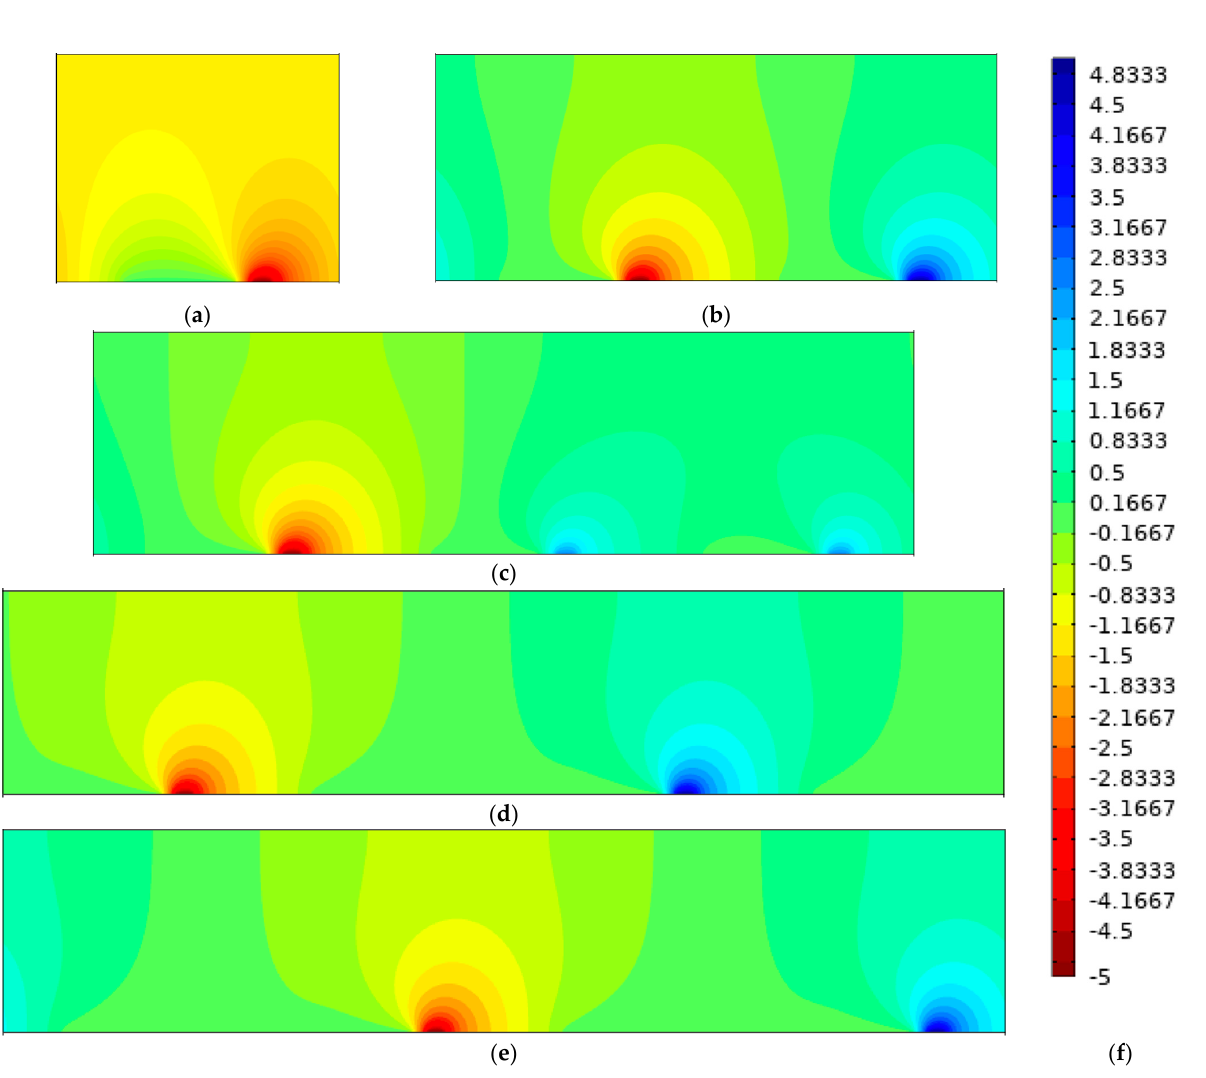
Figure 3. The real component of the voltage profiles is given for ( a ) 1-phase, ( b ) 2-phase (180 ◦ phase separation), ( c ) 3-phase (120 ◦ phase separation) and ( d ) 4-phase (90 ◦ phase separation) configurations at 5 V peak , where the far-left electrode is set to a phase angle of 0 ◦ . ( e ) shows the imaginary component of the electric field corresponding to the 4-phase configuration in ( d ). ( f ) shows the legend for the voltage contours used in color plots a-e. These simulations are shown for the electrode geometry of 150/120/20/20 µm.